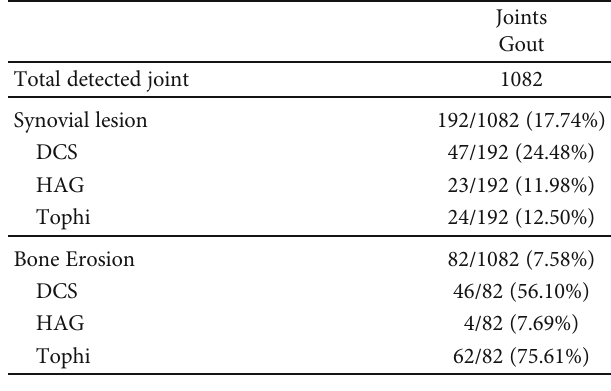
(a) Global US fi ndings in patients with gout and hyperuricemia (a) Synovial lesion and bone erosion in the patients with gout Patients